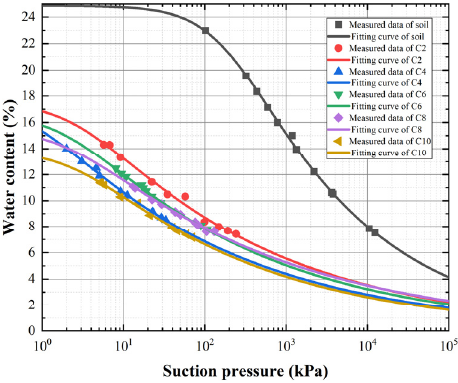
Figure 9. Changes in SWCCs under different action times of SMS-C.